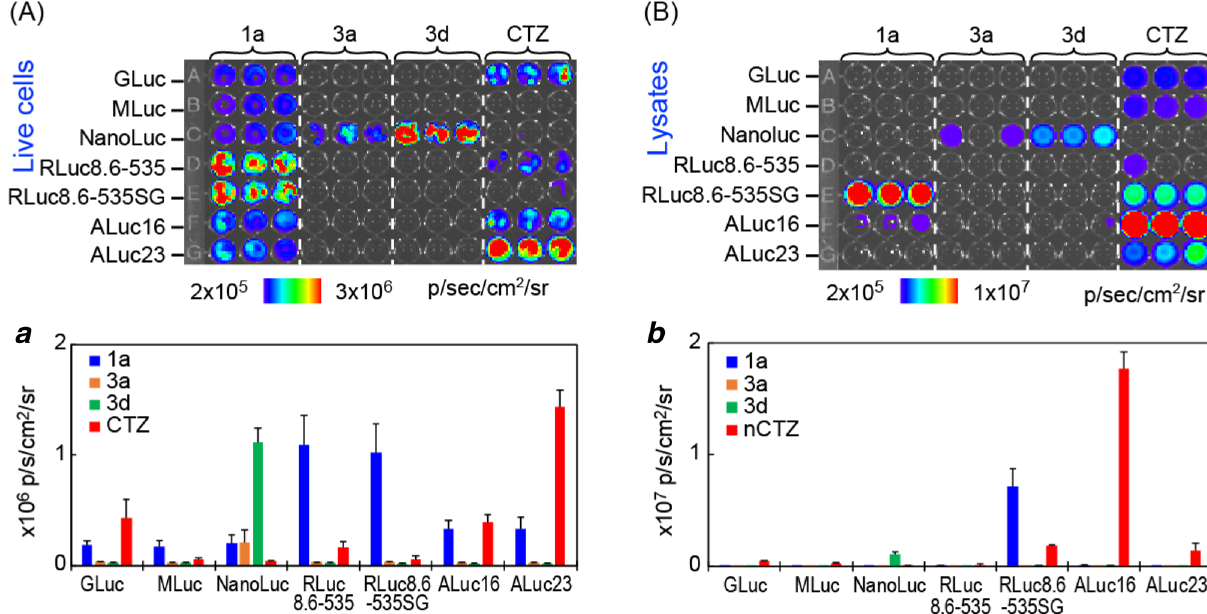
Figure 3. Luciferase-specific BLI of the selected CTZ analogues. ( A ) The BL image of selected CTZ analogues in live COS-7 cells. Inset a compares the BL intensities of the BL image. ( B ) The BL image of selected CTZ analogues in cell lysates. Inset b specifies the BL intensities of the BL